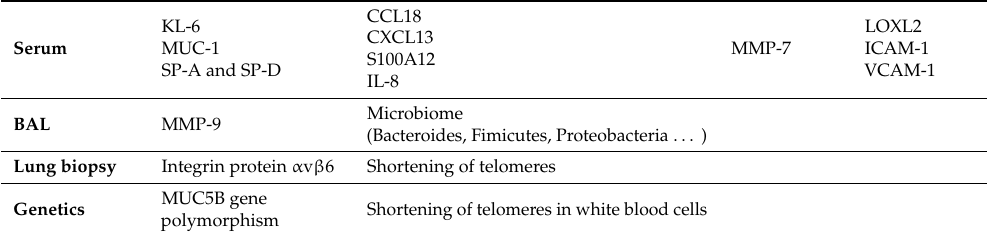
Table 2. Biomarkers related to idiopathic pulmonary fibrosis (IPF) worse prognostic.